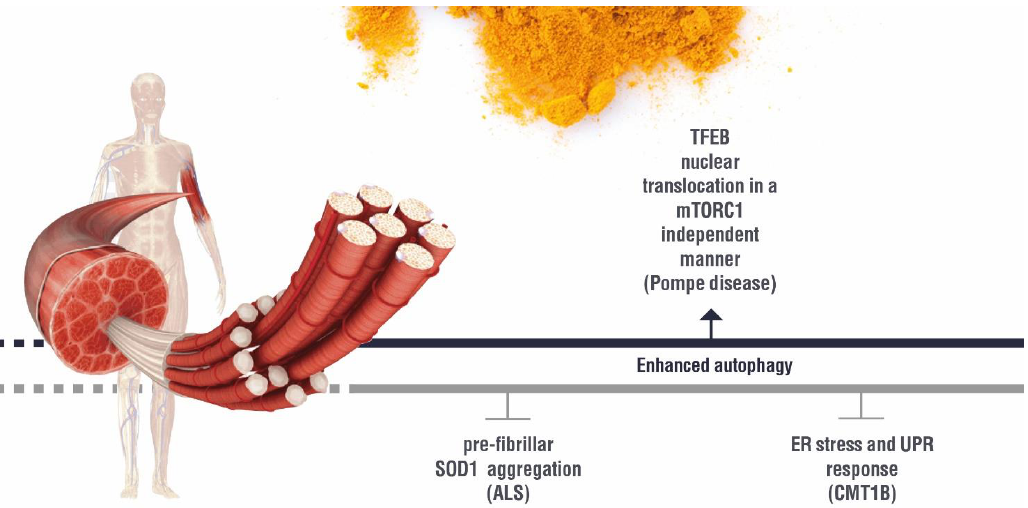
Figure 4. Overview of curcumin e ff ect on the autophagy pathways in neuromuscular diseases.Biological e ff ect of curcumin on the molecules involved in the autophagy regulation in the neuromuscular diseases discussed in the present review.